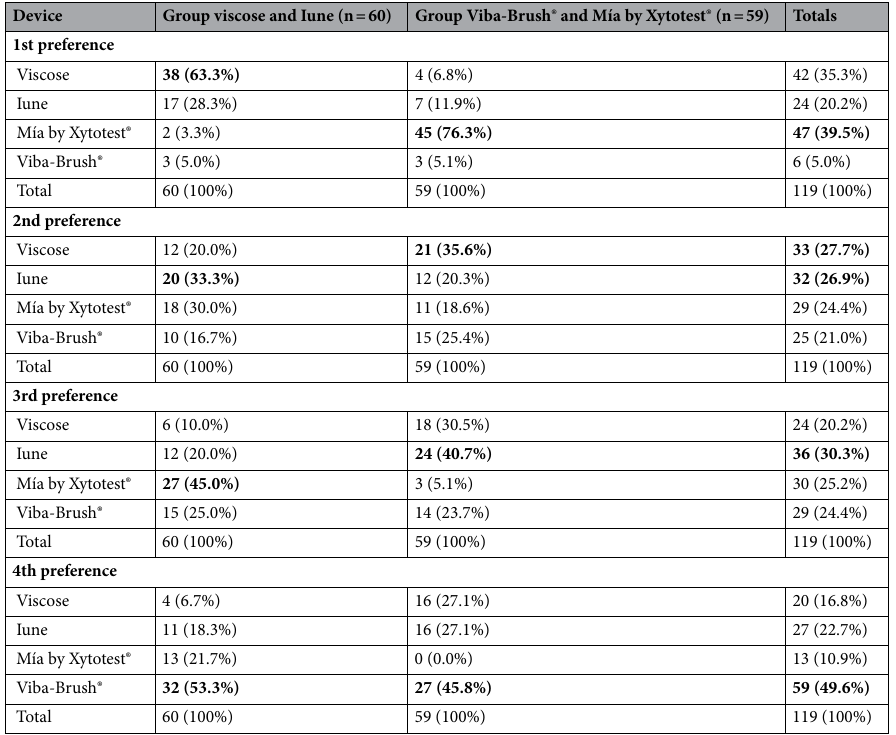
Table 6. Devices for self-samples ordered from highest to lowest preference of participants. The highest figures have been highlighted in